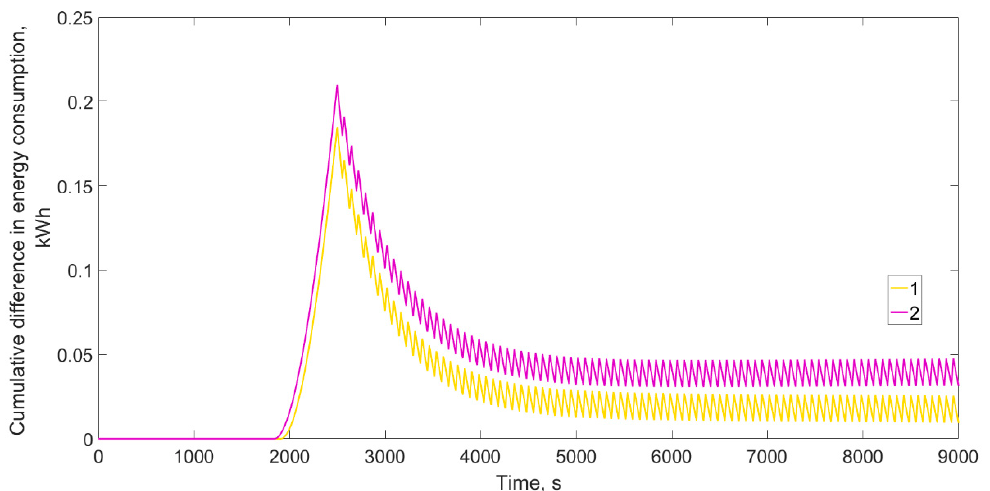
Figure 15. Course of the cumulative energy usage difference for control systems without noise 1—(relay—PID) and 2—(relay—I-PD).